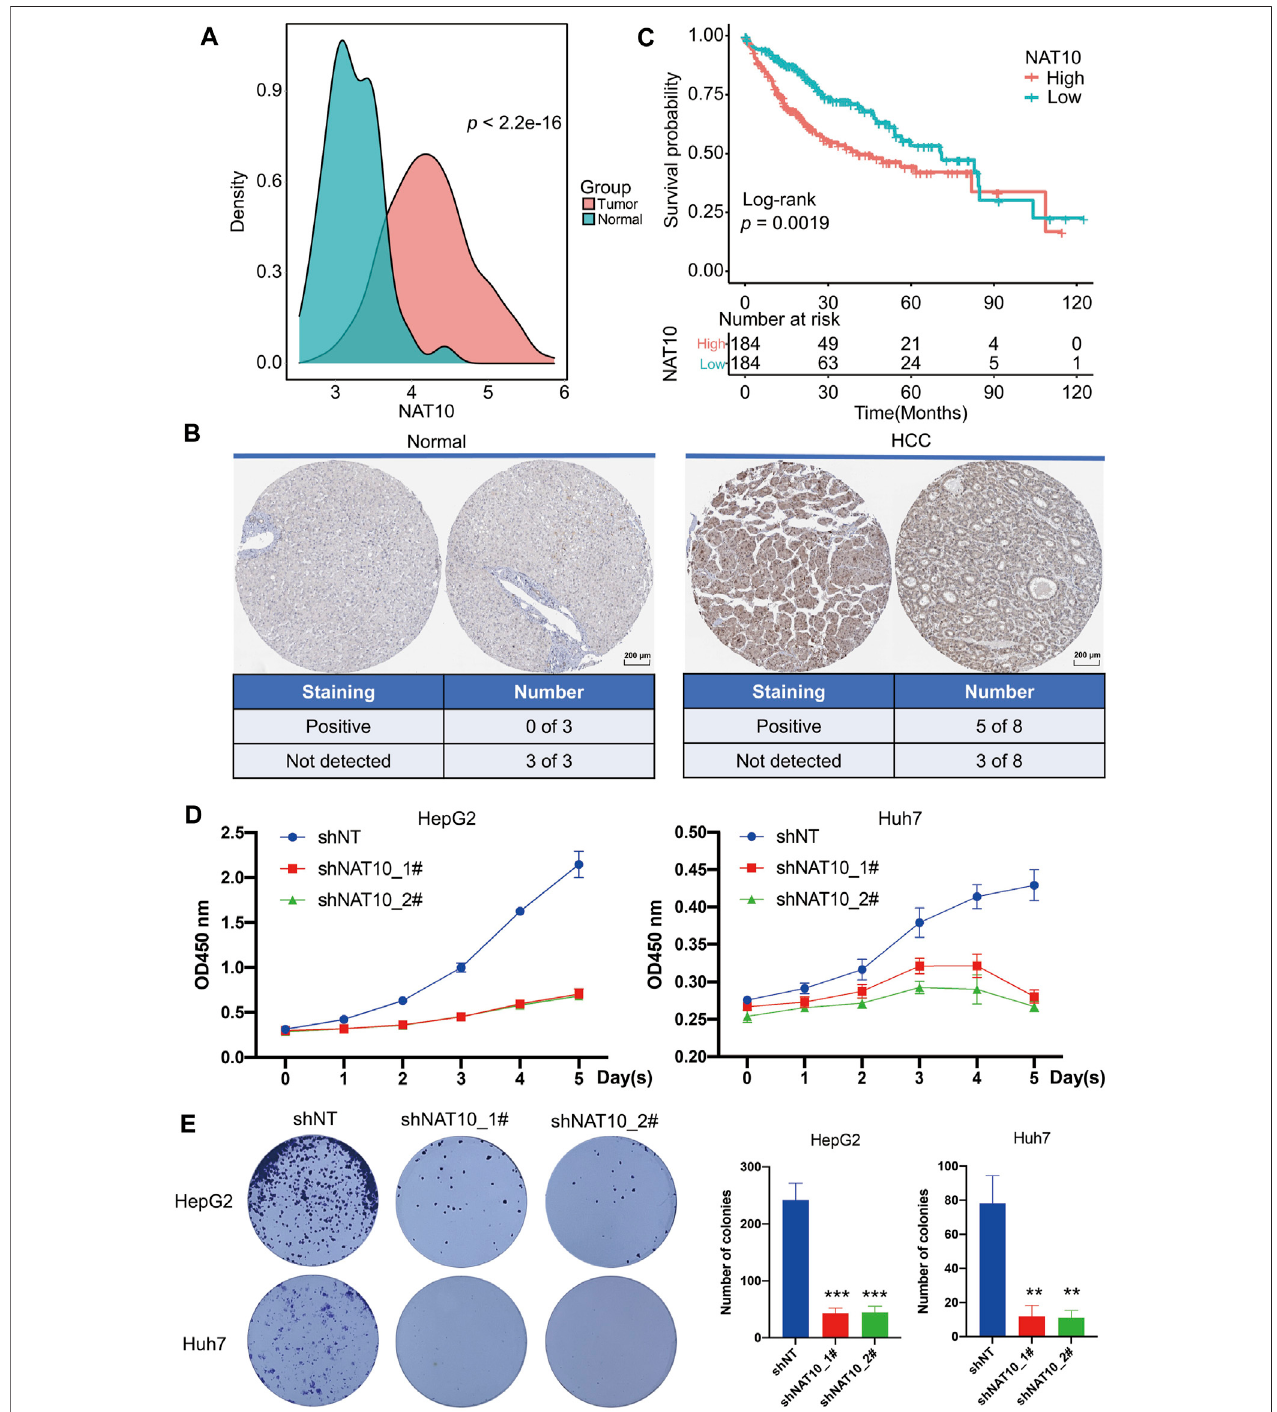
FIGURE1| PotentialoncogenicroleofNAT10inHCC. (A) DensityplotsshowtheexpressionofNAT10innormalandHCCsamples.Wilcoxtestwith p value < 0.05 isconsideredassigni fi cant. (B) RepresentativeimagesandstatisticsofIHCstainingforNAT10inlivertissuesandHCCfromtheHumanProteinAtlasdataset.Scalebar, 200 μ M. (C) SurvivalanalysisofNAT10inHCCpatients.Kaplan-Meiercurveswithlog-rank p values < 0.05areconsideredsigni fi cant. (D) CellproliferationofHepG2and Huh7cellsafterNAT10knockdownmeasuredwithCCK-8, n =3,datawereexpressedasmean±SEM. (E) CellproliferationofHepG2andHuh7cellsafterNAT10 knockdown measured with colony formation, n = 3. Left, representative image. Right, quantitative analysis, **, p < 0.01, ***, p < 0.001.